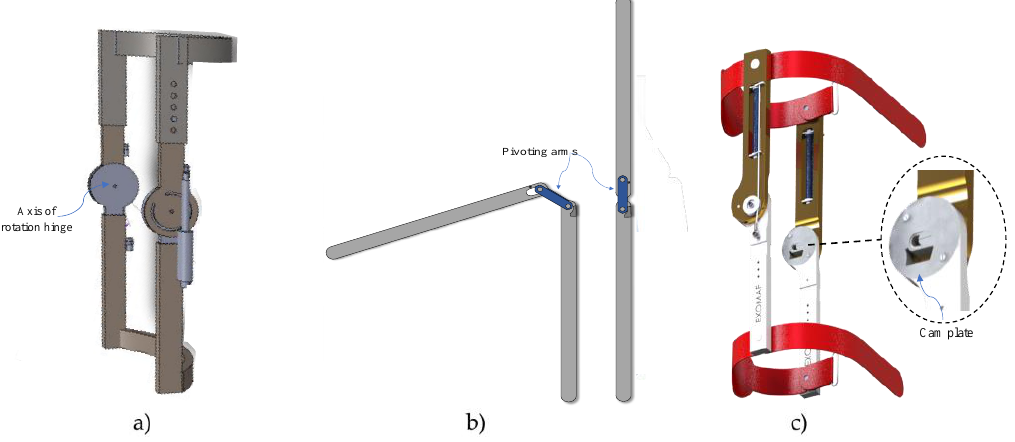
Figure 13. Type of union: ( a ) hinge; ( b ) pivoting arms; ( c ) cam.